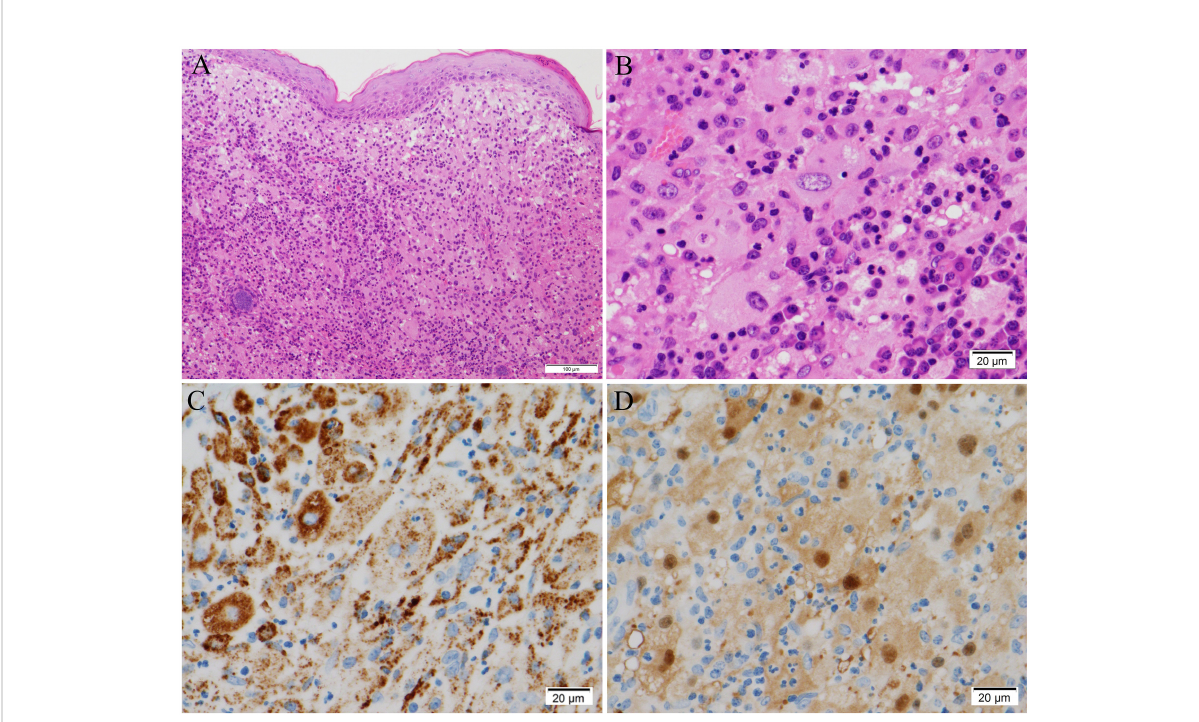
FIGURE 2 Histological fi ndings of the facial skin biopsy. (A, B) Hematoxylin and eosin staining, showing (A) large round cells aggregated diffusely in the upper dermis immediately beneath the epidermis, and (B) emperipolesis, in which lymphocytes and neutrophils are engulfed. (C, D) Immunohistochemical analysis, showing that the large round cells were positive for (C) CD68 and (D) S-100 protein. Original magni fi cations: × 100 (A) , × 400 (B – D) . Scale bars: 100 m m (A) and 20 m m (B – D)